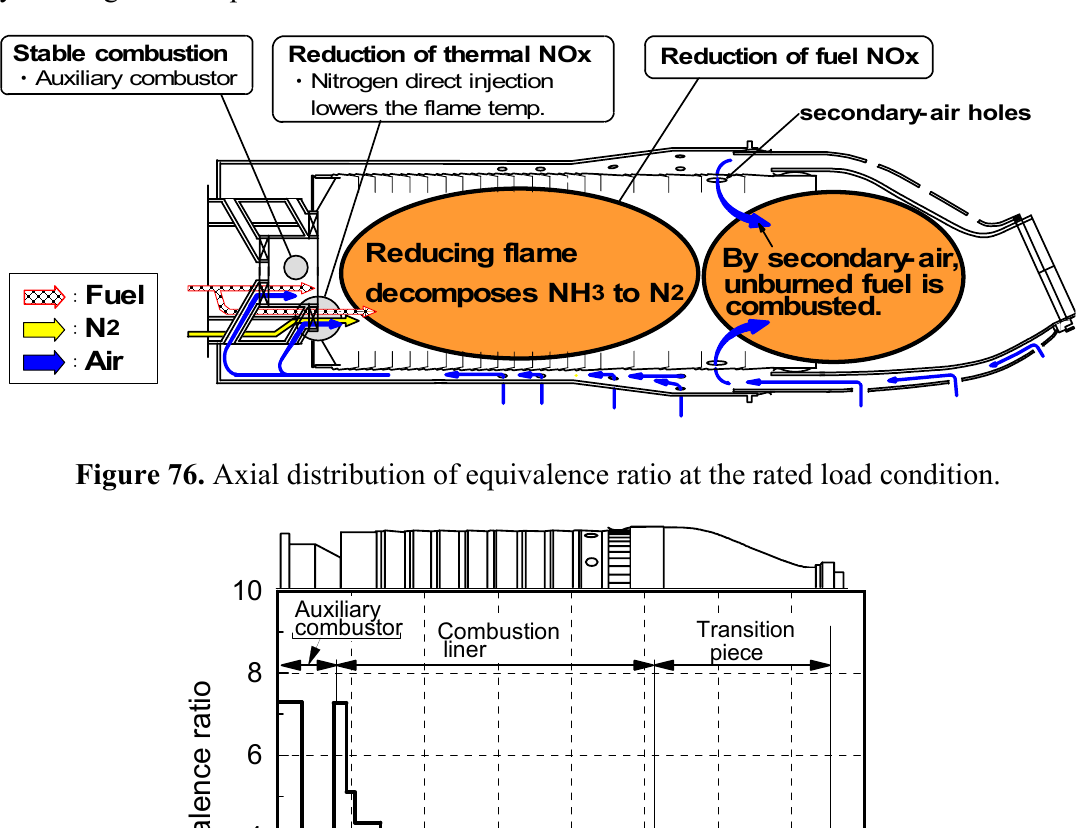
Figure 75. Design concept of medium-Btu fueled gas turbine combustor for hot/dry-type synthetic gas cleanup.